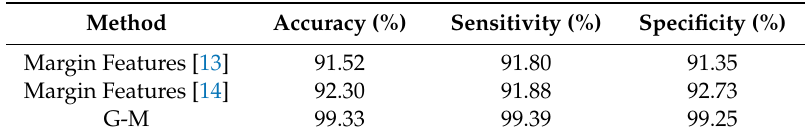
Table 6. Feature evaluation using RFC compared to the performance of shape-based features found in related studies using di ff erent